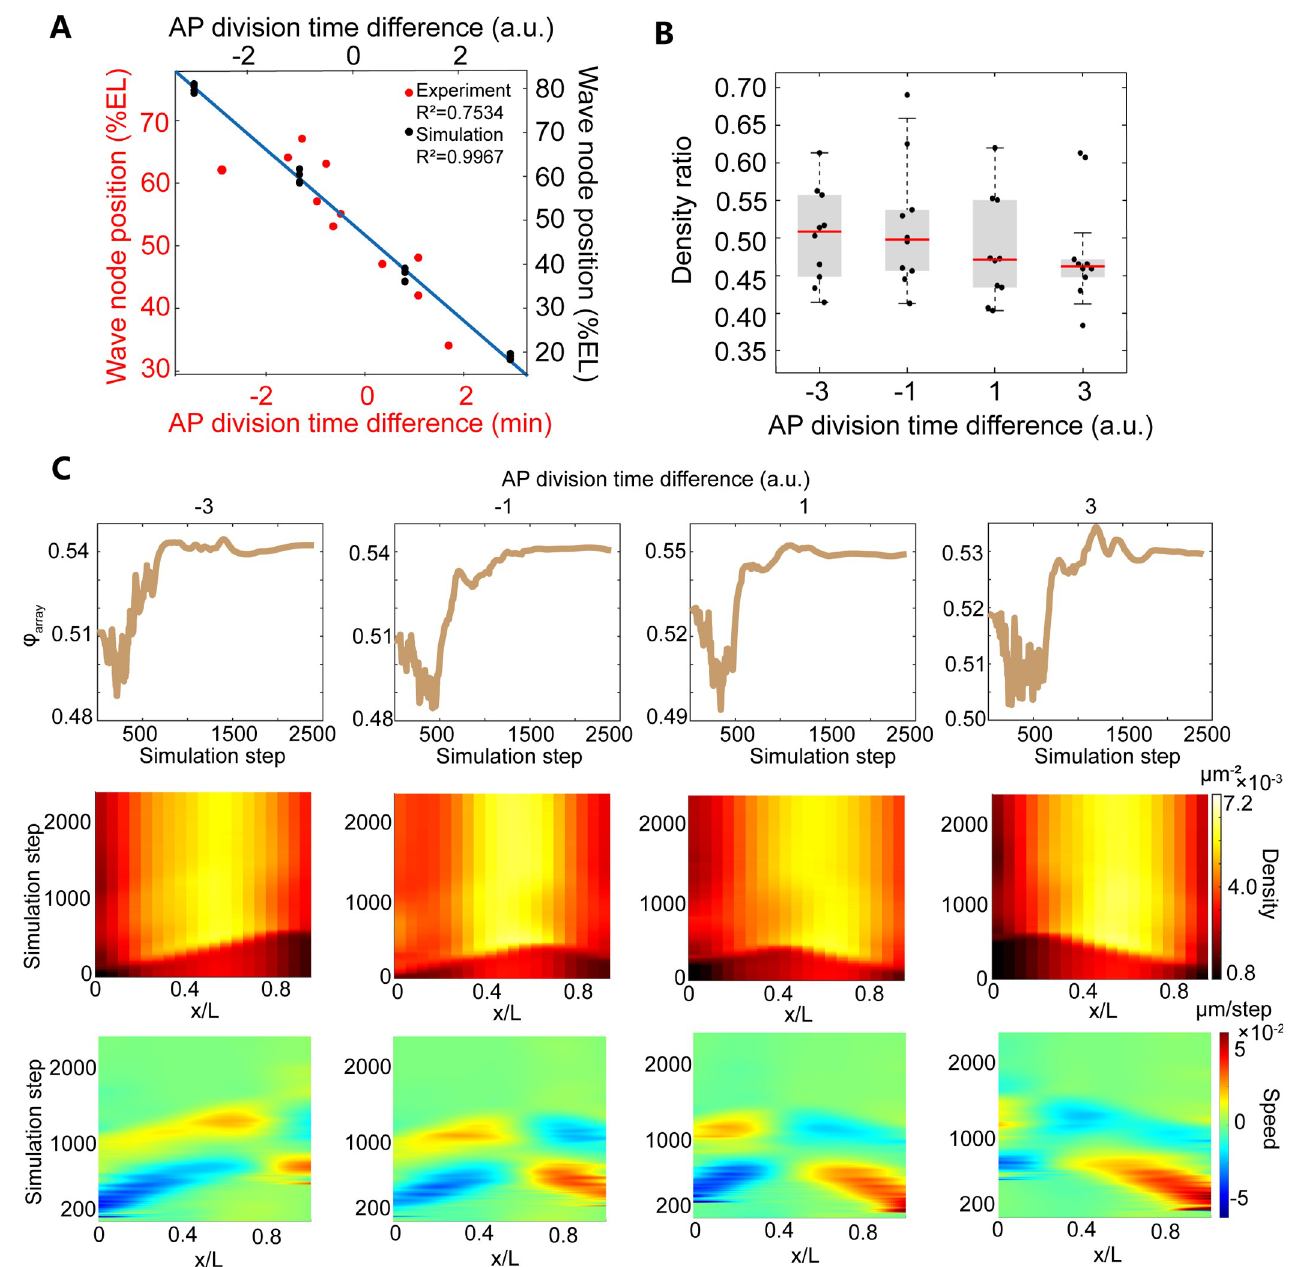
Fig 5. 3D simulation results of the embryos with varied start time of metaphase at two poles (F a force assumption). (A) The linear relation between the position of the second node of the standing wave of AP nuclear speed and the division time difference between the anterior and posterior poles of experimental (red) and simulation (black) data. (B) The density ratio of the simulation data with different AP division time difference. Boxplots (whisker, min/max values, boxes, 25/75 percentiles). The medians of the four group data in the panel are 0.51, 0.50, 0.47 and 0.46, respectively. (C) The representative characteristic features of the collective motion pattern and packing pattern of the nuclear array in the simulations with different AP division time difference. The force field used in this simulation is shown in S16A